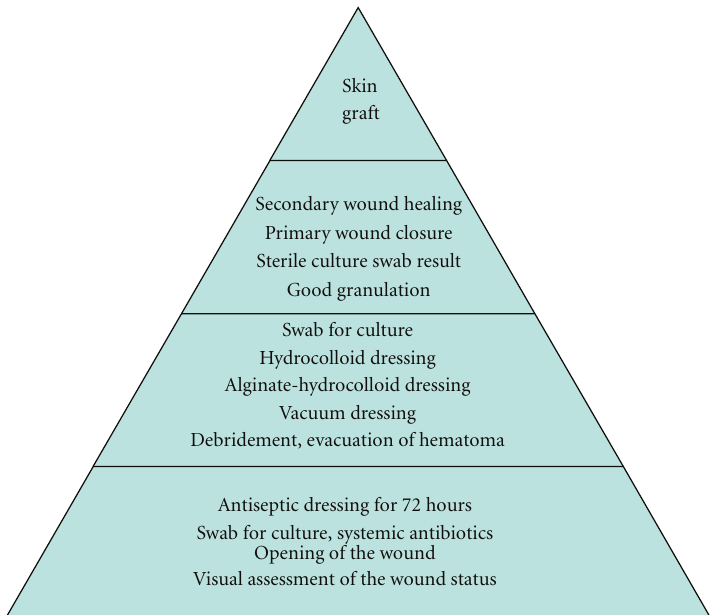
Figure 5: Staged schema for treatment of severe wound complications with escalation to skin graft coverage, depending on findings. With good progress of wound healing, a de-escalation of the therapy is possible at each